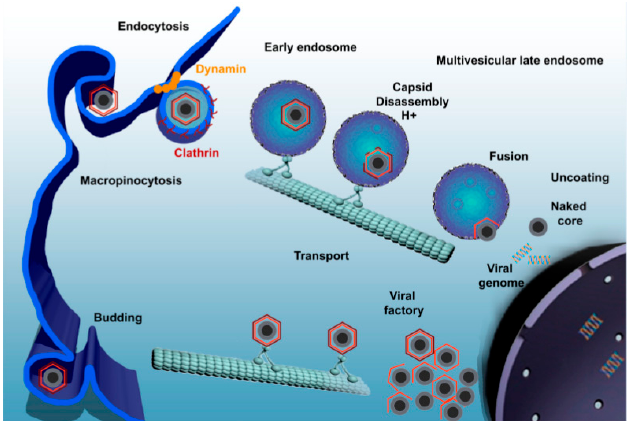
Figure 4. African swine fever virus (ASFV) enters the host cell through a complex process involving dynamin- and clathrin-mediated endocytosis and macropinocytosis. Newly synthesized virions are assembled in the viral factory and will exit the cell either by exocytosis budding at the plasma membrane or through the formation of apoptotic bodies [95].